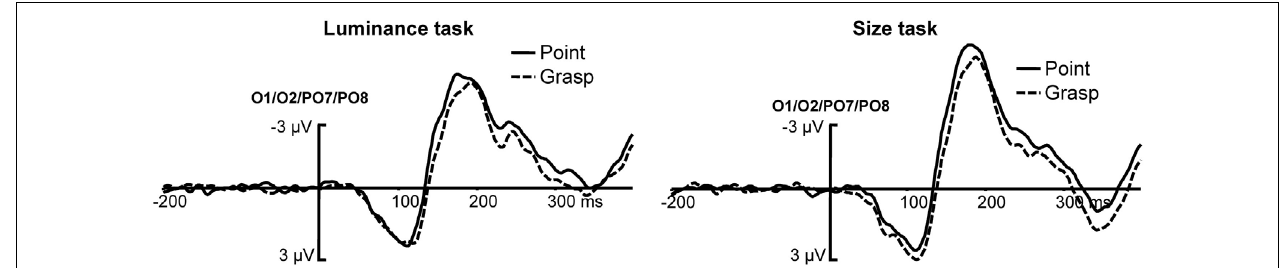
statistical analyses have been conducted. Solid line represents the pointing condition while the dashed line depicts the grasping